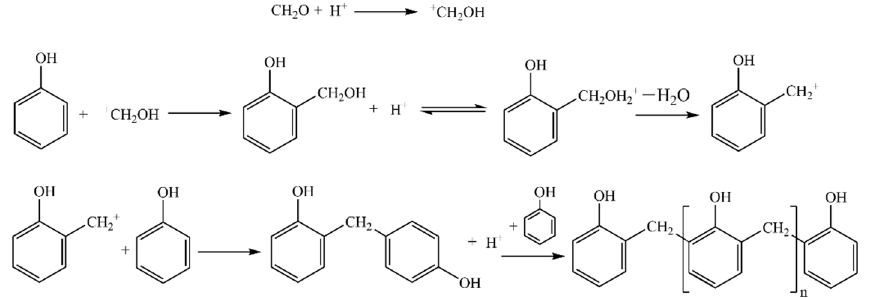
Figure 14. Synthesis process and structure of conventional phenolic resins without modification.